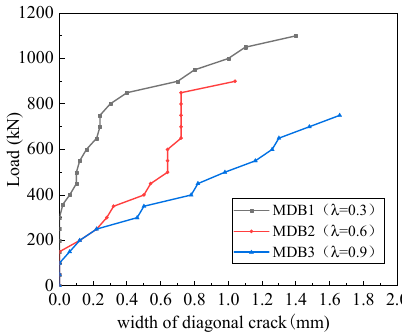
Figure 10. Relation curve between λ and horizontal distributing reinforcement strain.